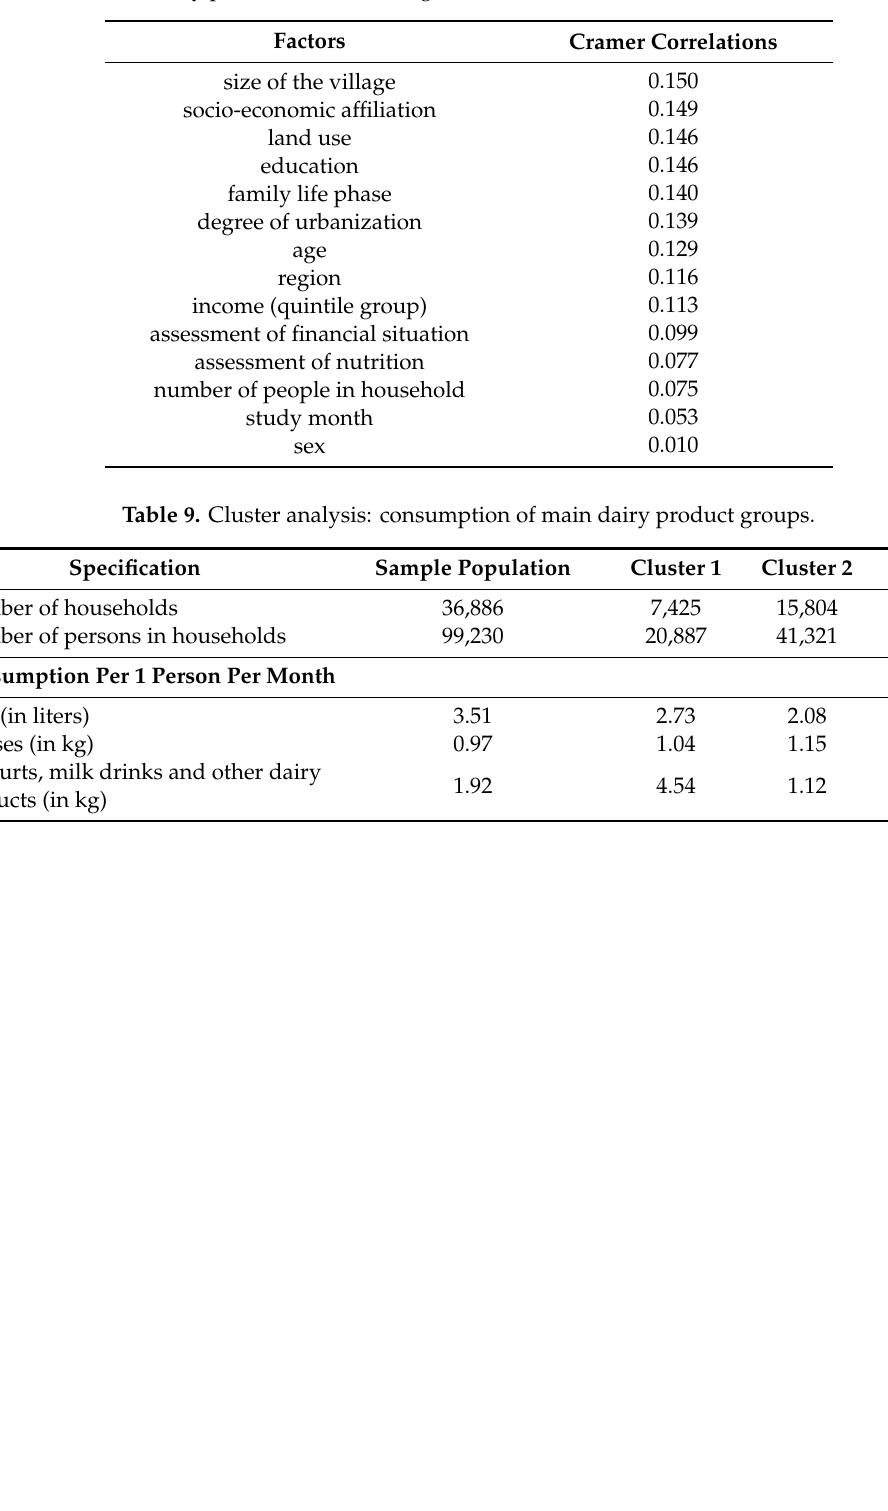
Table 8. Cluster analysis: impact of socio-demographic and economic factors on energy and nutrients contribution from dairy products in the average Polish diet.